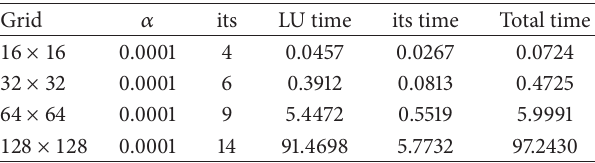
Table 7: Preconditioned GMRES(20) on steady Oseen problems with different grid sizes (uniform grids), viscosity V = 0.01 .